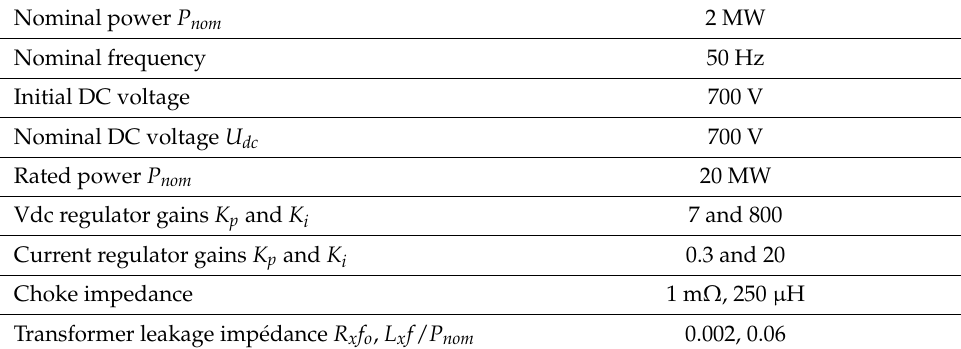
Figure 6. Simulink model of the studied PV plant. Table 2. Parameters of the controller.